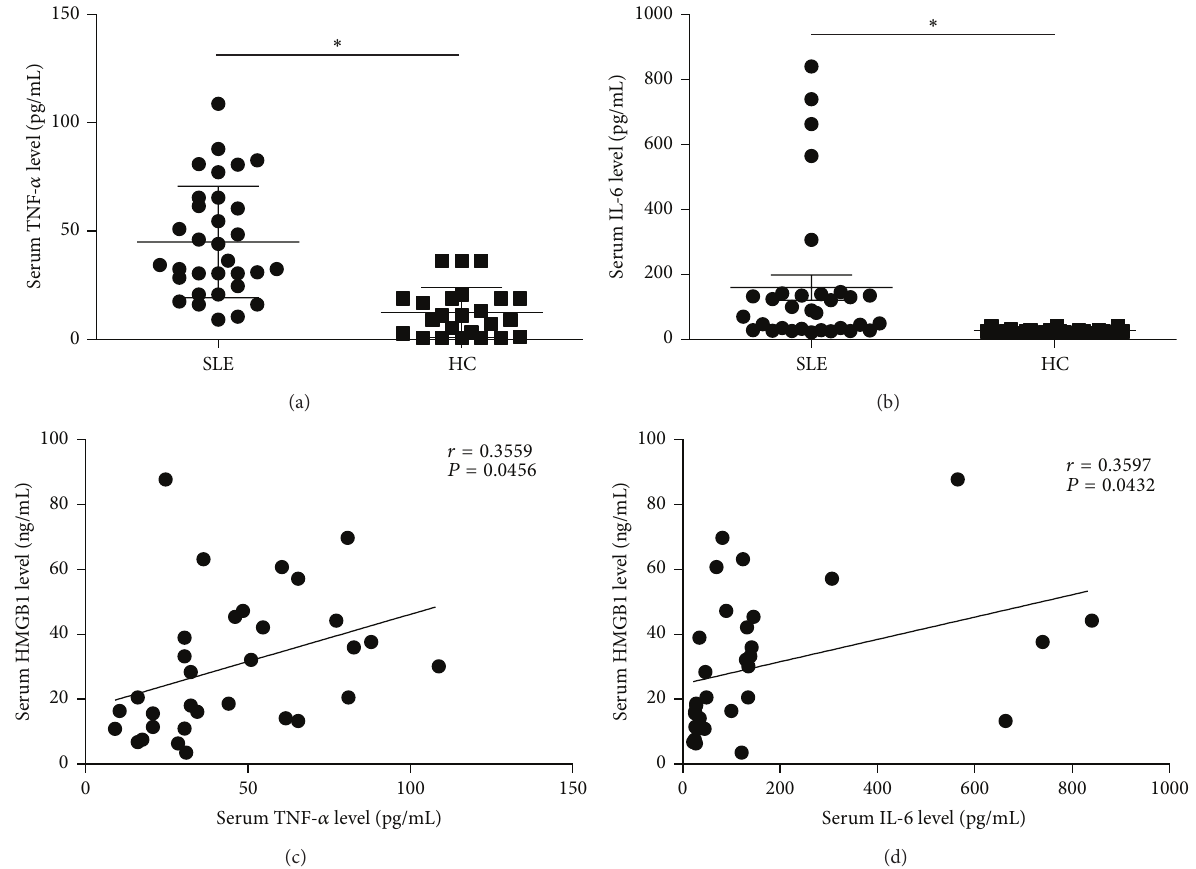
Figure 5: The HMGB1 levels were associated with proinflammatory cytokines in SLE patients. (a-b) TNF- 𝛼 (a) and IL-6 (b) concentrations in serafromSLEpatientsandHCweredetectedbyELISA.Thescatter-plotrepresentedtheTNF- 𝛼 andIL-6levelsbyELISAanalysis.Eachsymbol represents one SLE patient. Horizontal lines represent the median. Data represent the average from experiments performed in triplicates for eachpatient.(c-d)CorrelationanalyseswerepresentedbetweenHMGB1andTNF- 𝛼 levels(c),HMGB1andIL-6levels(d).Pearsoncorrelation analysis was used in the correlation analysis. ∗ 𝑃 < 0.05